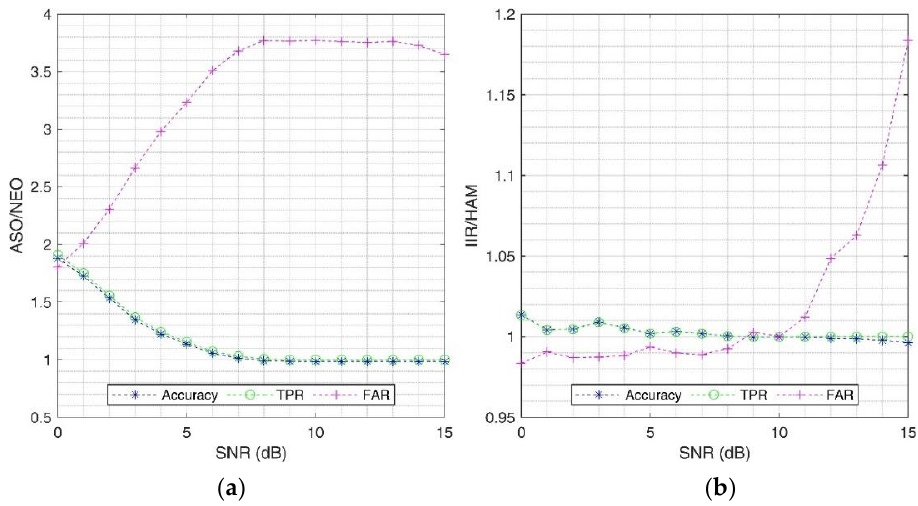
Figure 11. ( a ) Detection differences between ASO and NEO with Hamming FIR filter and noise ground true; ( b ) Detection differences between of ASO with Hamming FIR filter and its equivalent IIR version, both with WA as noise